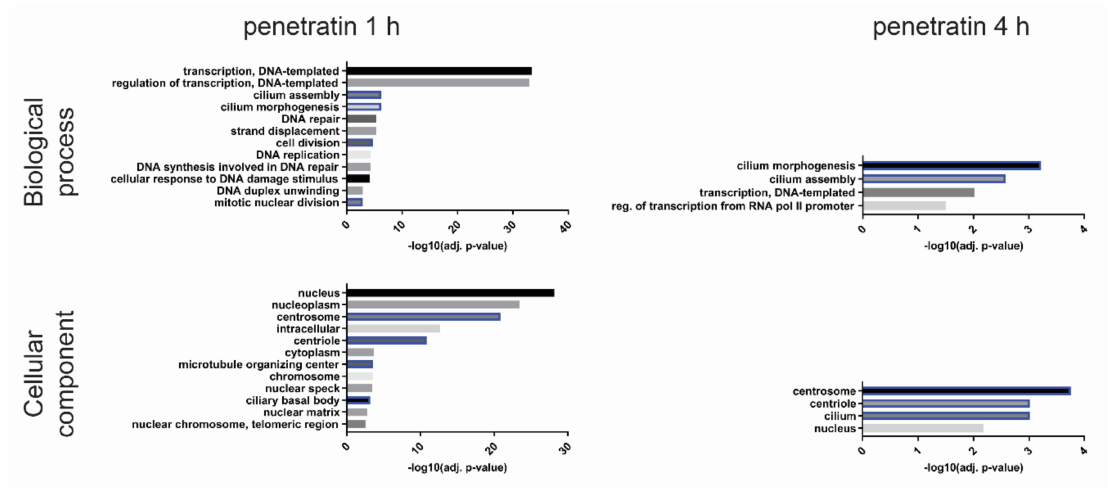
Figure 3. Gene ontology analysis of downregulated genes after 1- or 4-h treatment with penetratin. Gene ontology terms related to microtubules and centrosome structure are marked blue. Molecular function and KEGG Pathway GO annotation groups are not showed as they do not contain any relevant GO